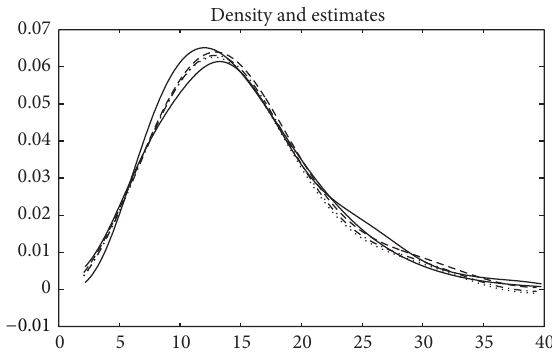
Figure 1: Estimates of gamma density through double exponential noise for 𝑛 = 400 . The thick solid line is the true density, the thin solid line and the dashed line are the kernel estimator and the SC estimator when 𝑓 𝜀 is known, respectively, and the dot-dashed line andthedottedlinearetheSCestimatorswhenthenoisesamplesizes 𝑀 = 50 and 𝑀 = 10 , respectively. Density and estimates